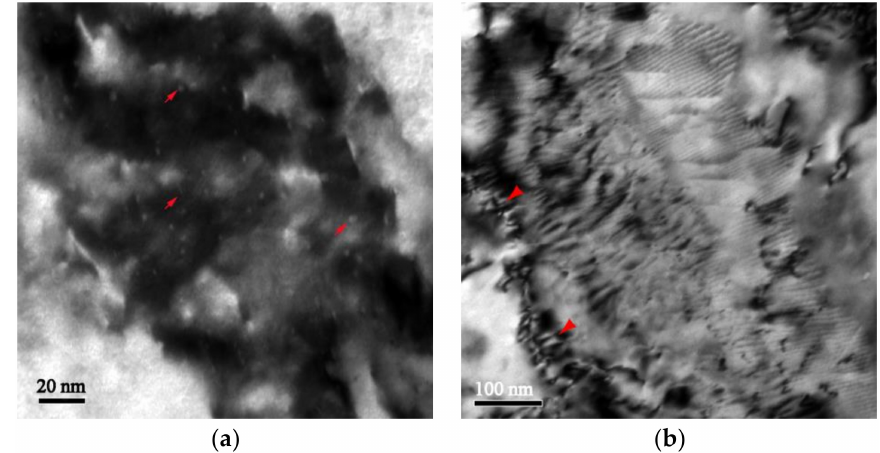
Figure 8. Bright-field transmission electron microscopy (TEM) micrographs and SAED of the studied alloy aged at 723 K for 240 min: ( a ) dislocations and second phase precipitates; and ( b ) pinned dislocations. Table 1. The related parameters in the yield strength calculations, data from [36,38,40]. Parameter Description Value Units References Shear modulus of